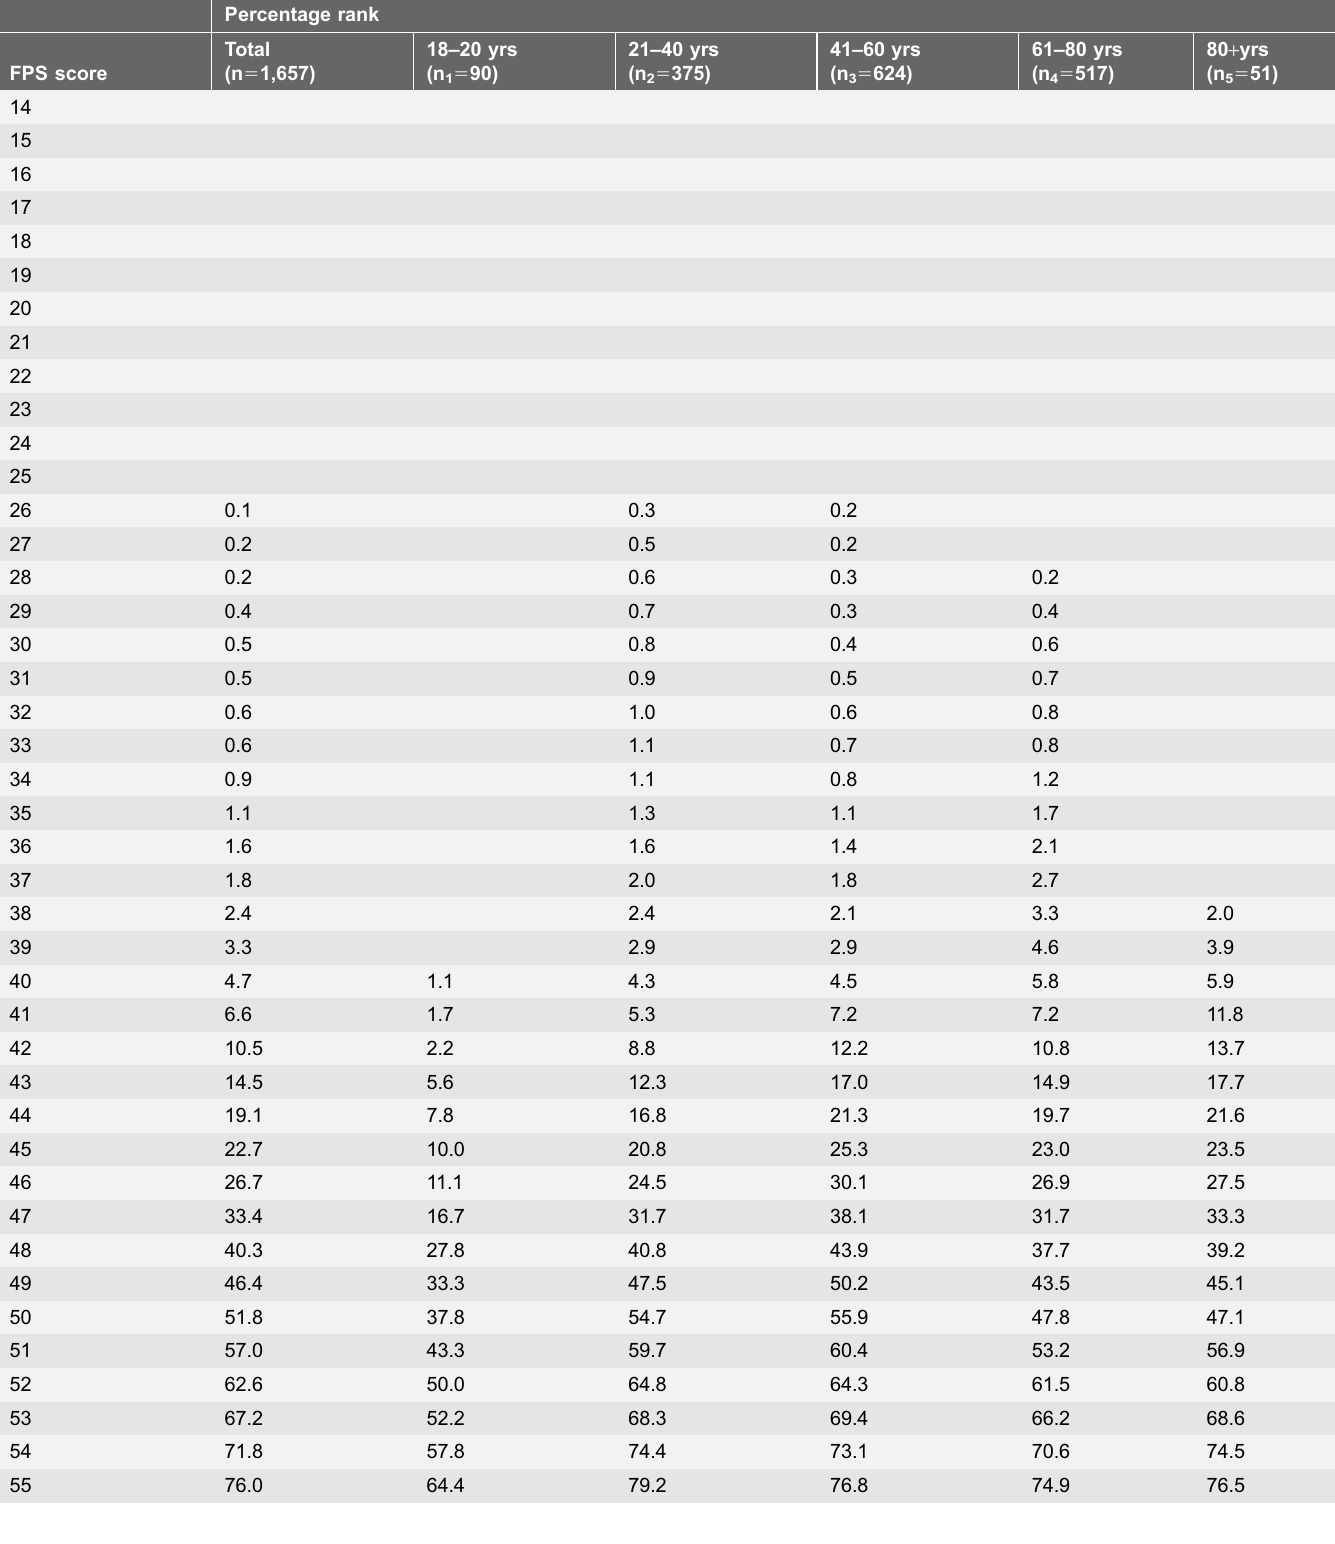
Table 5. Reference values (percentages) for the FPS score and the weighted FPS score for the total sample (n 5 1,657) and for different age